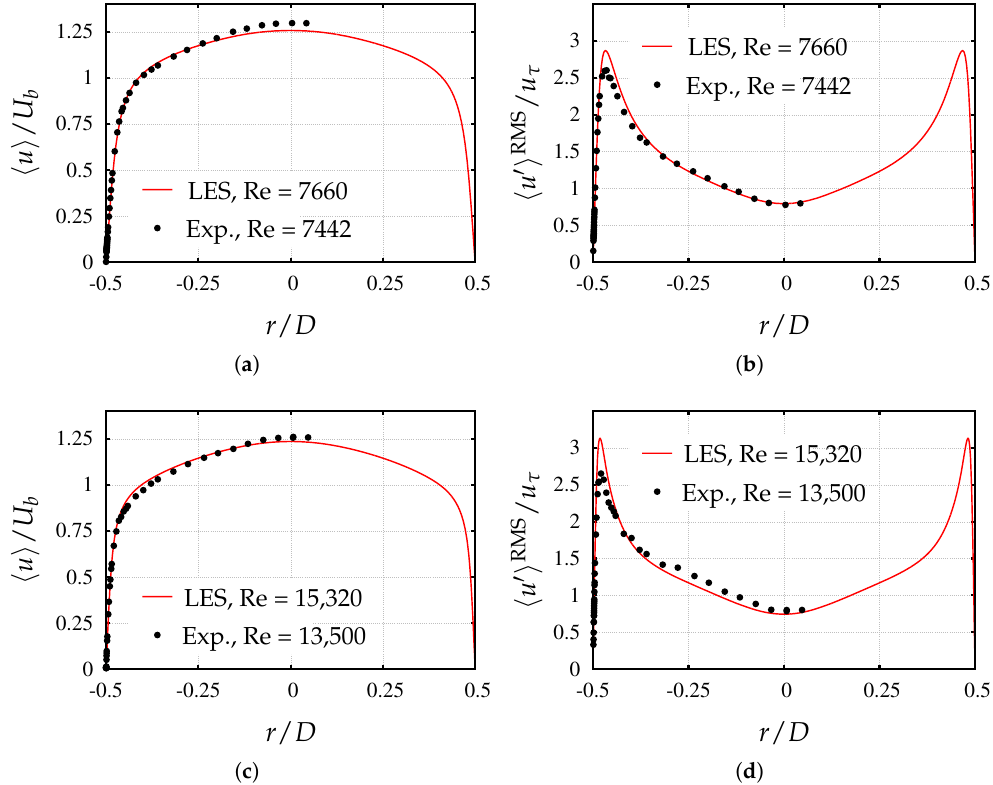
Figure 8. Validation of the inflow data. The experimental measurements are provided by Durst et al. [68]. ( a ) Mean streamwise velocity, Re L . ( b ) Streamwise RMS velocity fluctuations, Re L . ( c ) Mean streamwise velocity, Re H . ( d ) Streamwise RMS velocity fluctuations, Re H . Furthermore, the root-mean-squared (RMS) velocity fluctuations in streamwise direc- tion normalized by the friction velocity (cid:104) u (cid:48) (cid:105) RMS / u τ are shown in Figure 8b,d for Re L and Re H , respectively. The maximum fluctuations are found with a sharp peak in the region close to the wall. Towards the center of the pipe, the fluctuations decrease and reach a minimum at the center line. Some discrepancies between the measured and predicted peaks are recognizable especially for the Re H case. The peaks of the streamwise velocity fluctuations are higher in the simulations than in the experiment. Moreover, it is worth mentioning that the fluctuations in the other two directions, i.e., the radial and tangential directions are additionally compared and found to be in reasonable agreement. For the sake of brevity these results are not provided here. In summary, a satisfactory agreement between the measurements and the simulation results exists ensuring that the inflow data applied in the bend flow simulations are